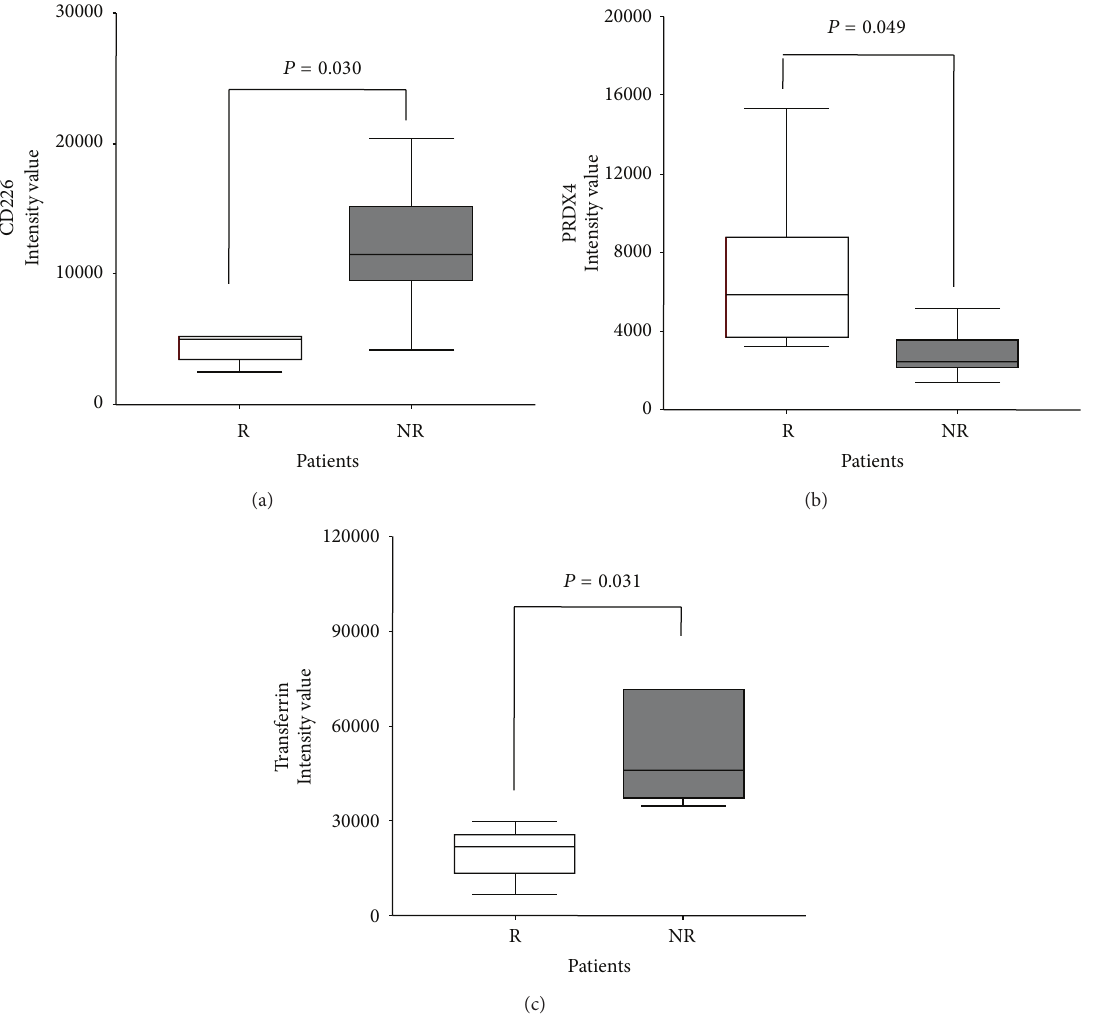
Figure 5: Platelet protein expression of CD226 (a), PRDX4 (b), and transferrin (c) in NR and R patients (R: empty box-plots; NR: dark